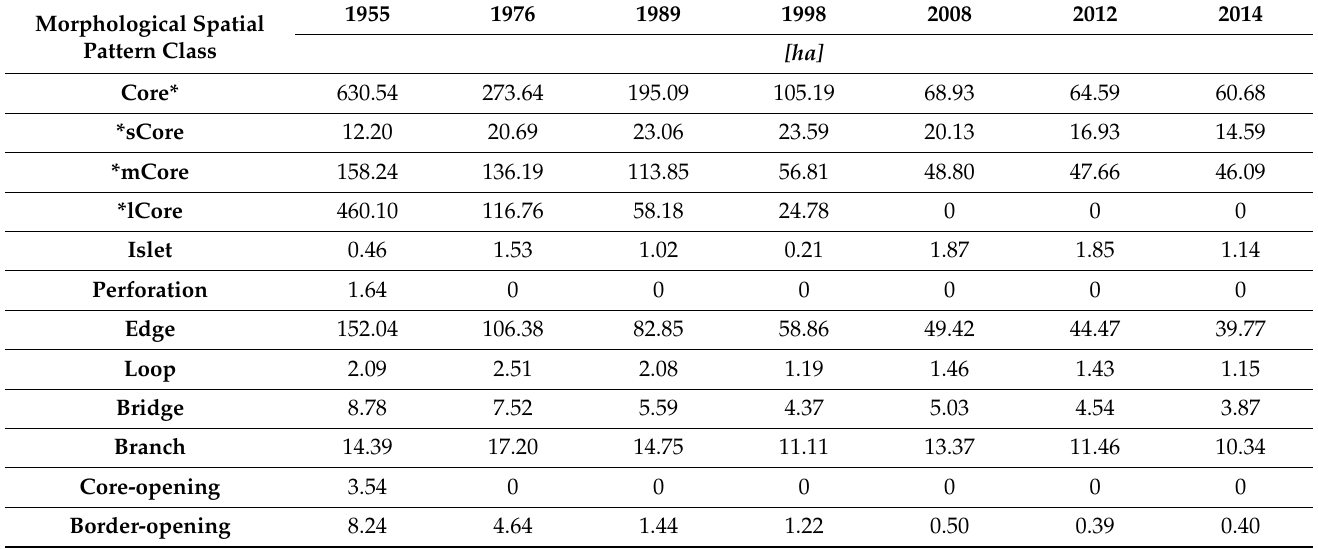
Figure 5. Spatial morphological pattern class composition of the study area for each of the years investigated. Table 4. The total surface occupied by morphological spatial pattern classes analysed for each of the years investigated.